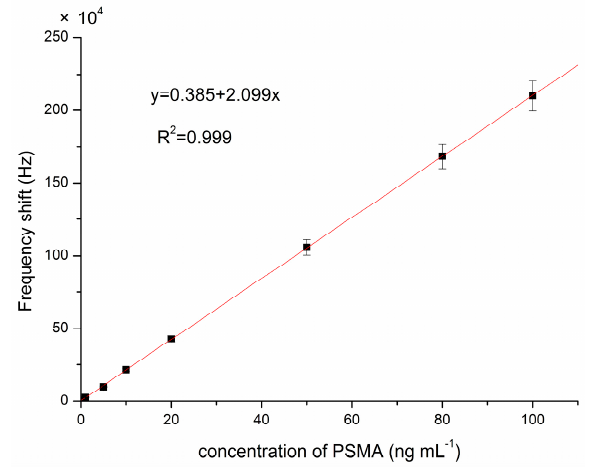
Figure 5. Calibration curve of this method.